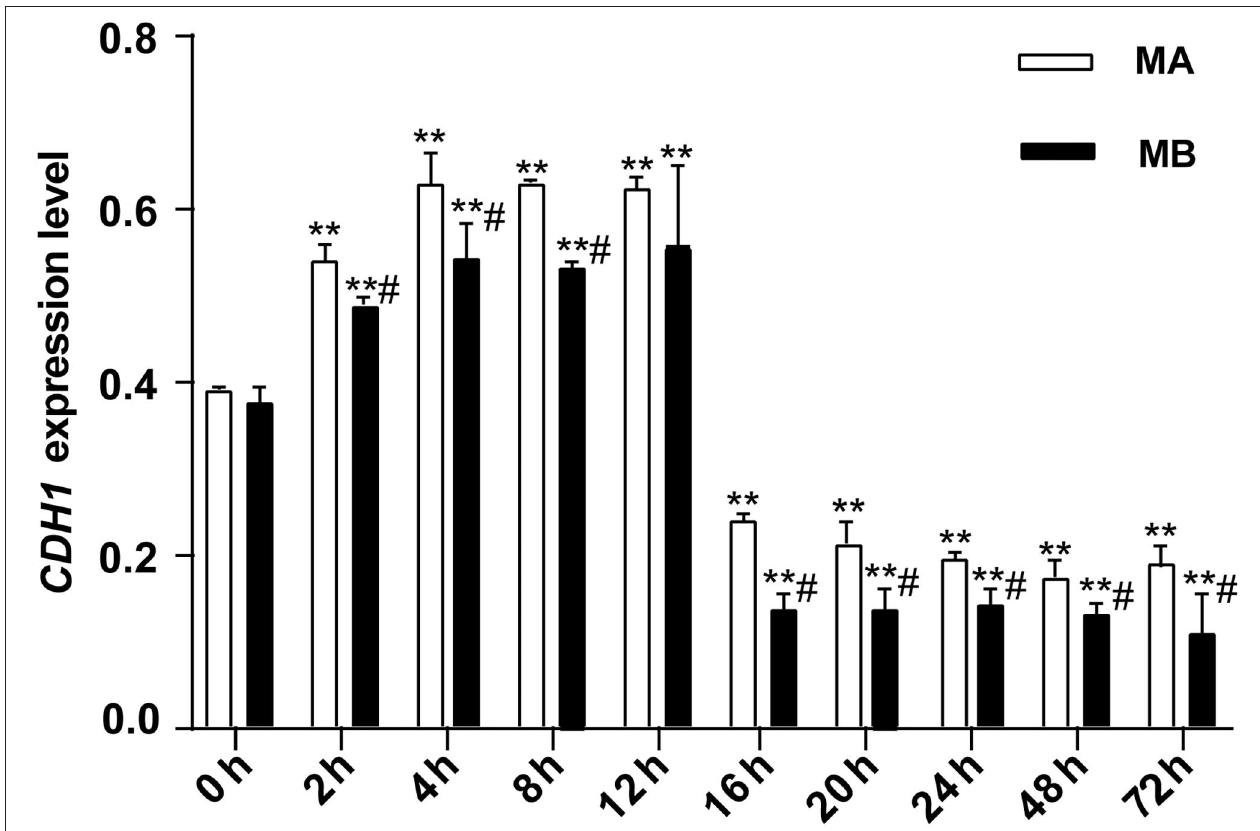
FIGURE 4 | The relative expression of CDH1 mRNA at different culture times ( n = 9). CDH1 expression in rumen explants was measured to determine the activity of rumen explants in different culture media and different culture times and to further determine the optimal culture time and medium for the explants. The expression of CDH1 was stable rising before 12h but decreasing after 16h and remaining at a low expression level till the cultured end at 72h. One-way ANOVA in SPSS 22.0 software was used to analyze the data, presented as mean ± sd. The ratio of all gene expression levels compared to the housekeeping gene β -actin was obtained as the relative expression of the gene. # Indicates significant difference compared to other groups at the same time or the same concentration gradient ( p < 0.05). **Indicates a highly significant difference ( p < 0.01).